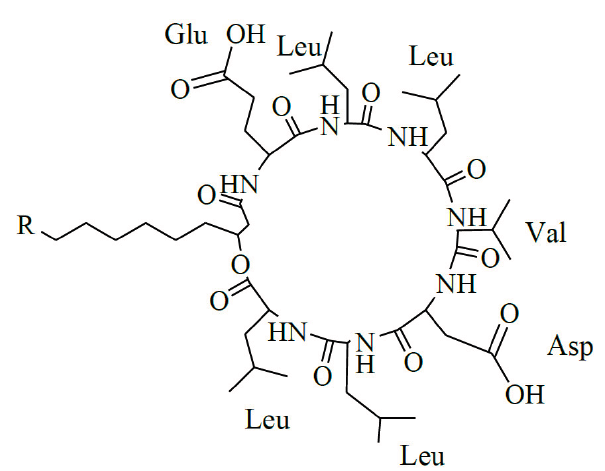
Figure 1. The structure of surfactin C13 (R = C 4 H 9 ), C14 (R = C 5 H 11 ), C15 (R = C 6 H 13 )